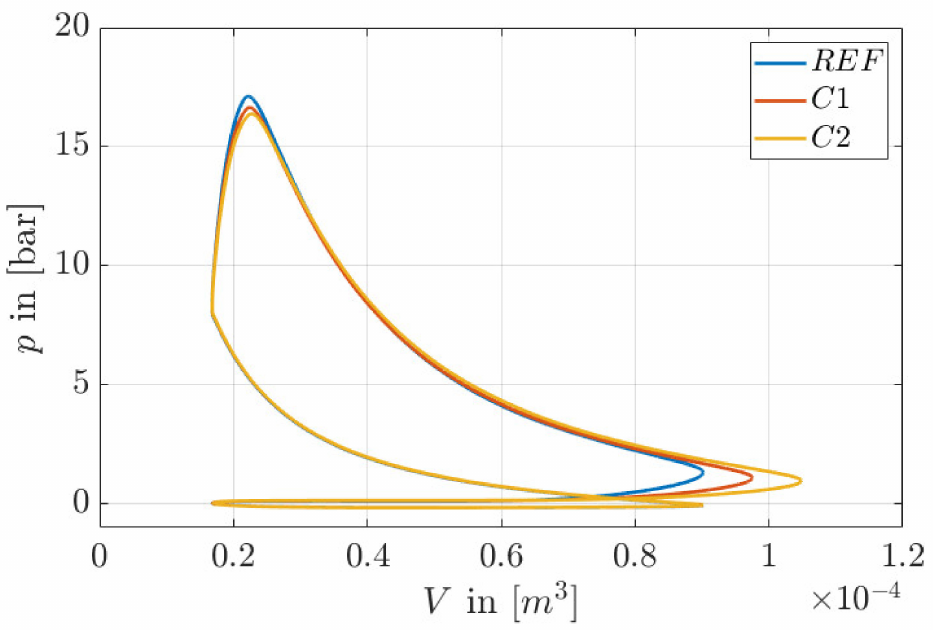
Figure 26. Comparison of trajectories REF, C1 and C2 related to the energy conversion of the internal combustion engine: cylinder pressure depending on volume.